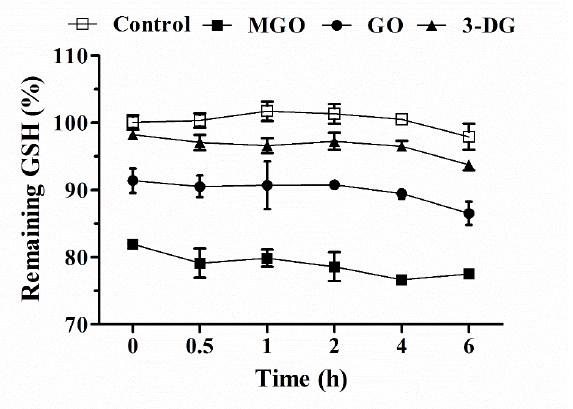
Figure 4. The change in GSH content after incubation of GSH (0.5 mM) with MGO (0.5 mM), GO (0.5 mM) or 3 ‐ DG (0.5 mM) in 25 mM potassium phosphate (pH = 7.4, 37 ° C ) for 0, 0.5, 1, 2, 4, and 6 h. Data are presented as mean ± SEM of three independent replicates.